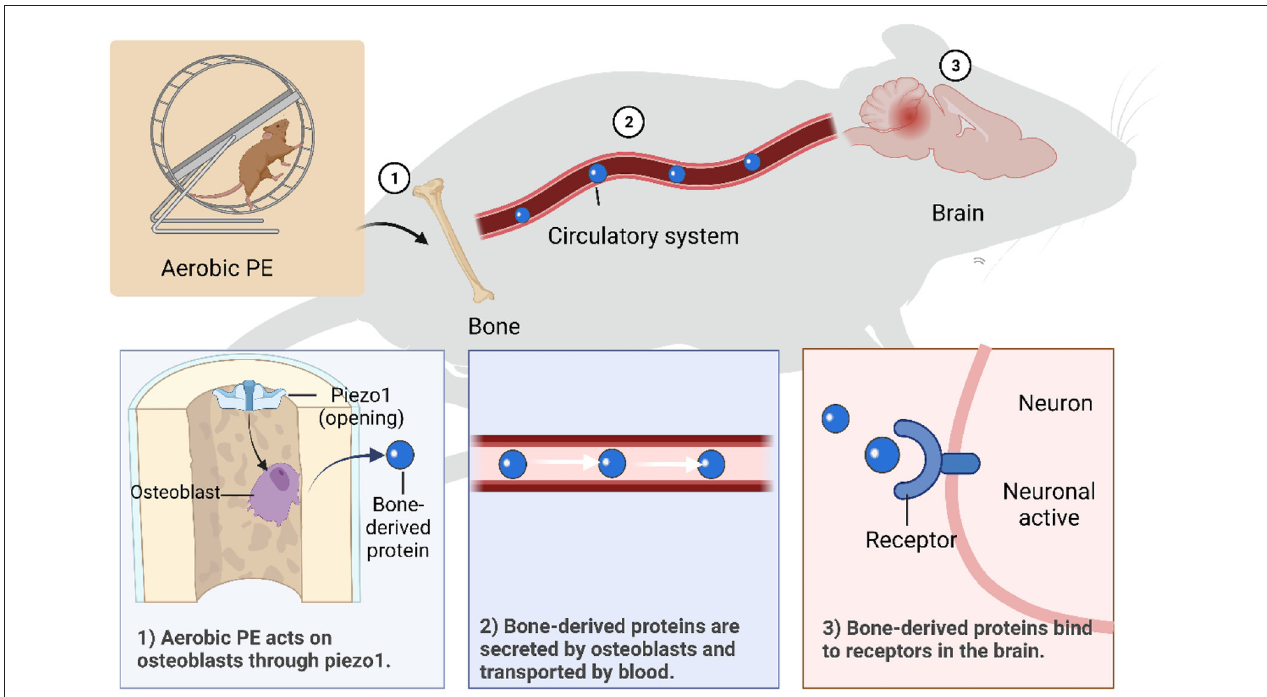
FIGURE 2 | Mechanisms of aerobic PE intervening in brain dysfunction through bone-brain axis. (1) Piezo1 is activated by aerobic PE, which promotes osteoblast growth and secretion of bone- derived proteins. (2) Bone-derived proteins are transported in blood and can cross the blood-brain barrier. (3) Bone-derived proteins bind to specific receptors on neurons to